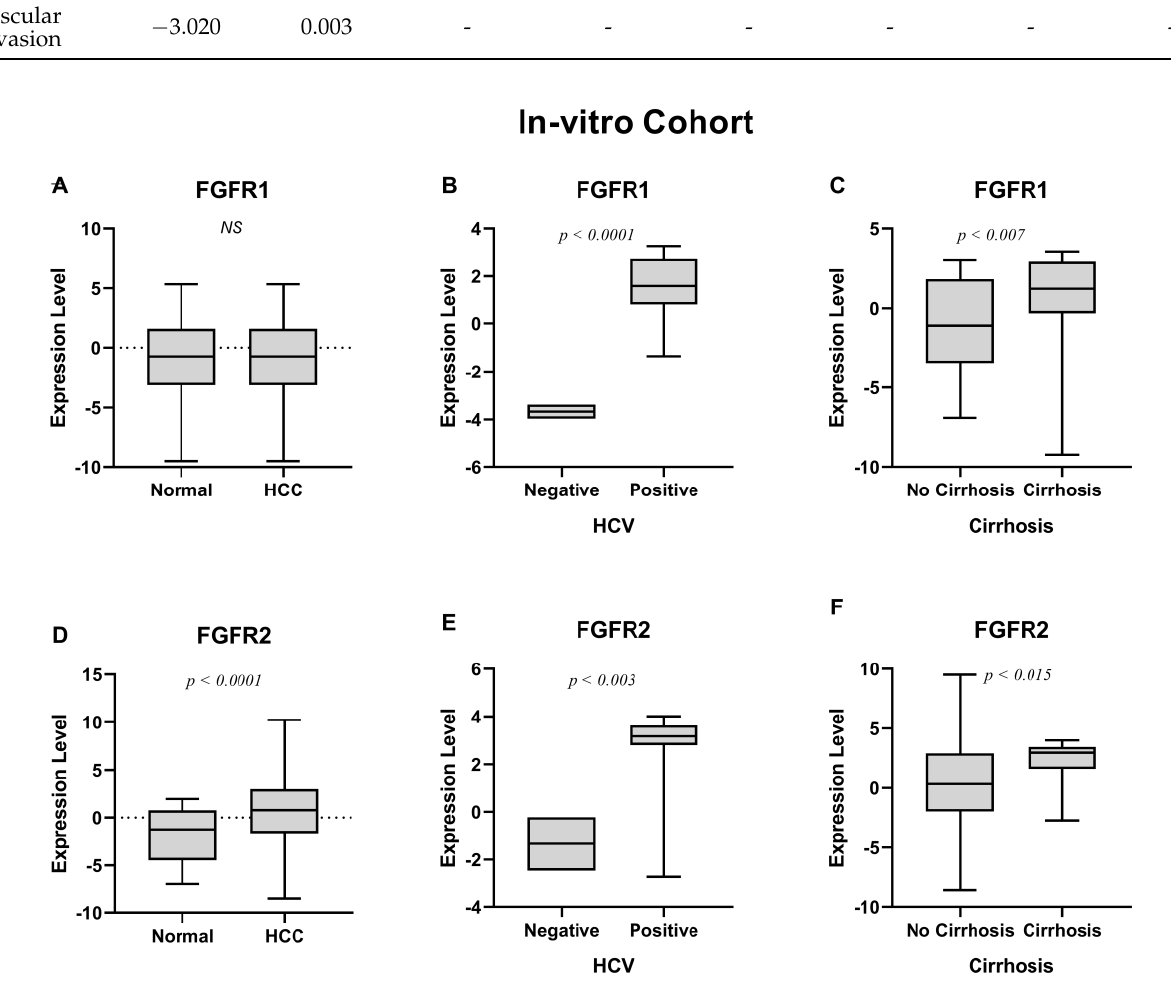
Figure 1. ( A ) FGFR1 expression in HCC shows no significant p -value. ( B ) Upregulation of FGFR1 in HCV+ patients. ( C ) FGFR1 upregulation in cirrhosis. ( D ) Overexpression of FGFR2 in HCC. ( E ) Upregulation of FGFR2 in HCV+ patients. ( F ) FGFR2 upregulation in cirrhosis.